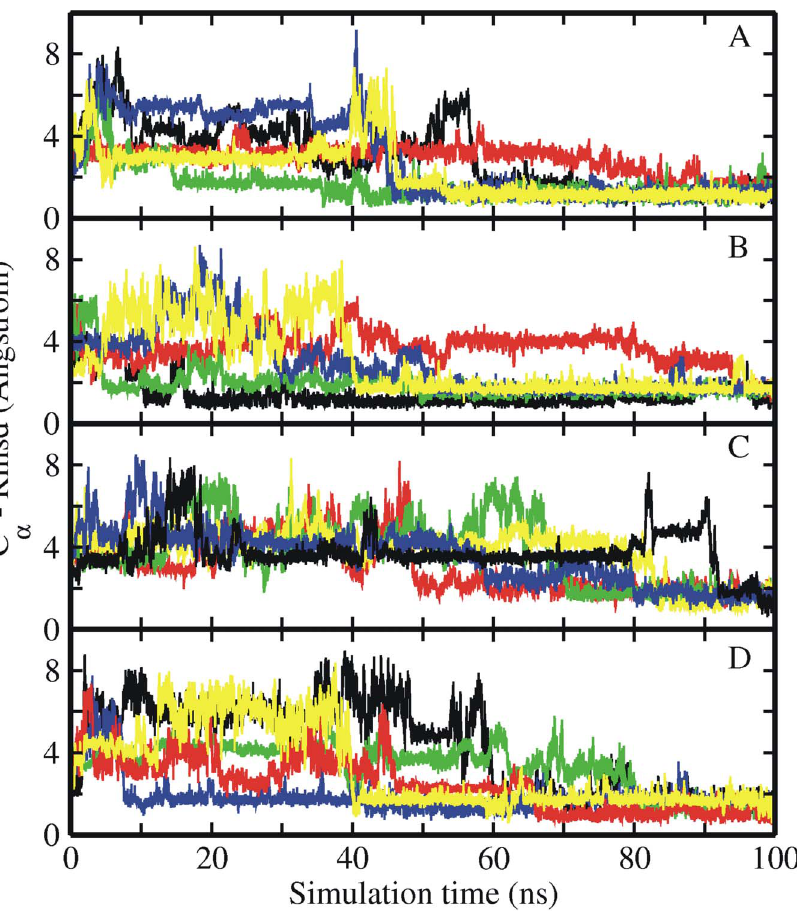
Figure 5. MD simulations of intermediate Trp-cage structures. RMSD C a of sampled Trp-cage conformations in explicit solvent starting from a set of intermediate structures (a subset of intermediate structures of set2 shown in Figure 5B,) vs. simulation time with different Amber force fields (A) ff03 (B) ff99SB, (C) ff99SB_ILDN, (D) ff99SB_NMR. All these examples eventually reached a near-native conformation with RMSD C a , 2 A˚ from the native Trp-cage structure.